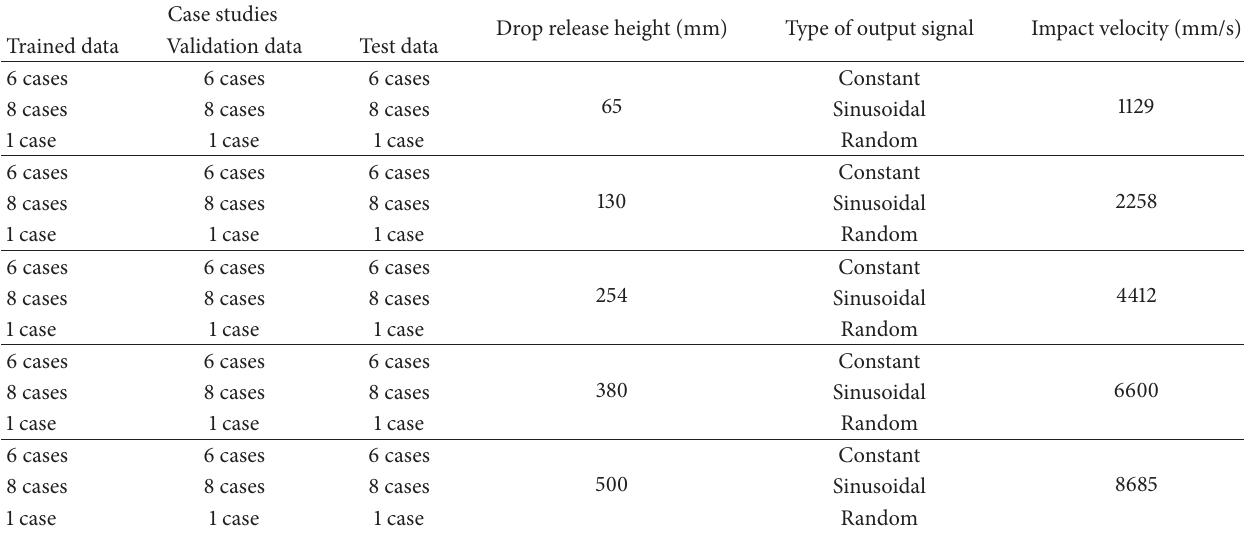
Table 1: Experimental test details.